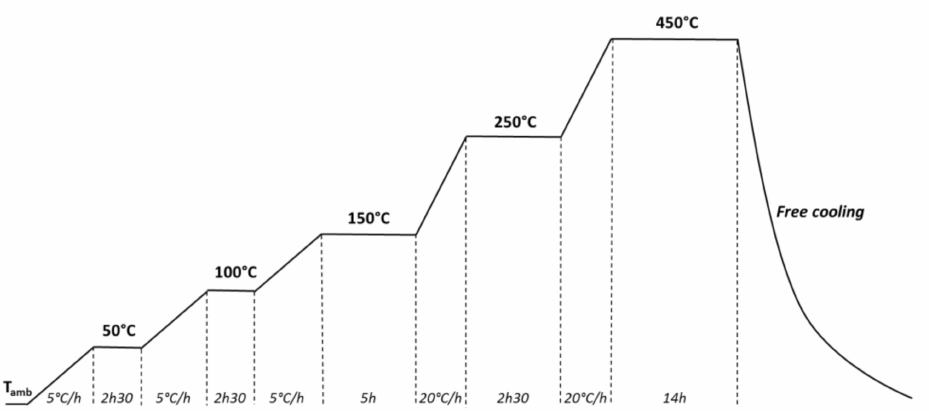
Figure 1. Scheme of the calcination